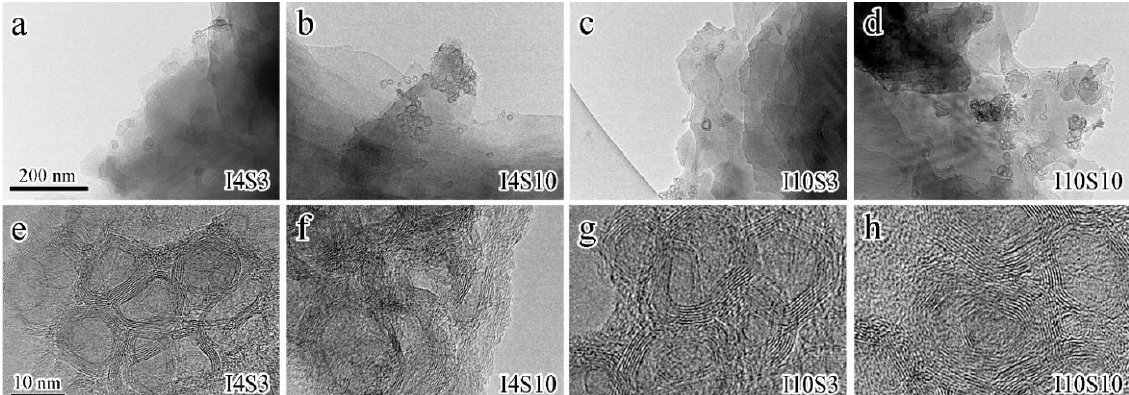
Figure 9. The TEM images of specimens recycled from NaCl electrolyte. ( a – d ), low magnification images of I4S3, I4S10, I10S3, and I10S10, respectively; ( e – h ), high magnification images of I4S3, I4S10, I10S3, and I10S10, respectively.